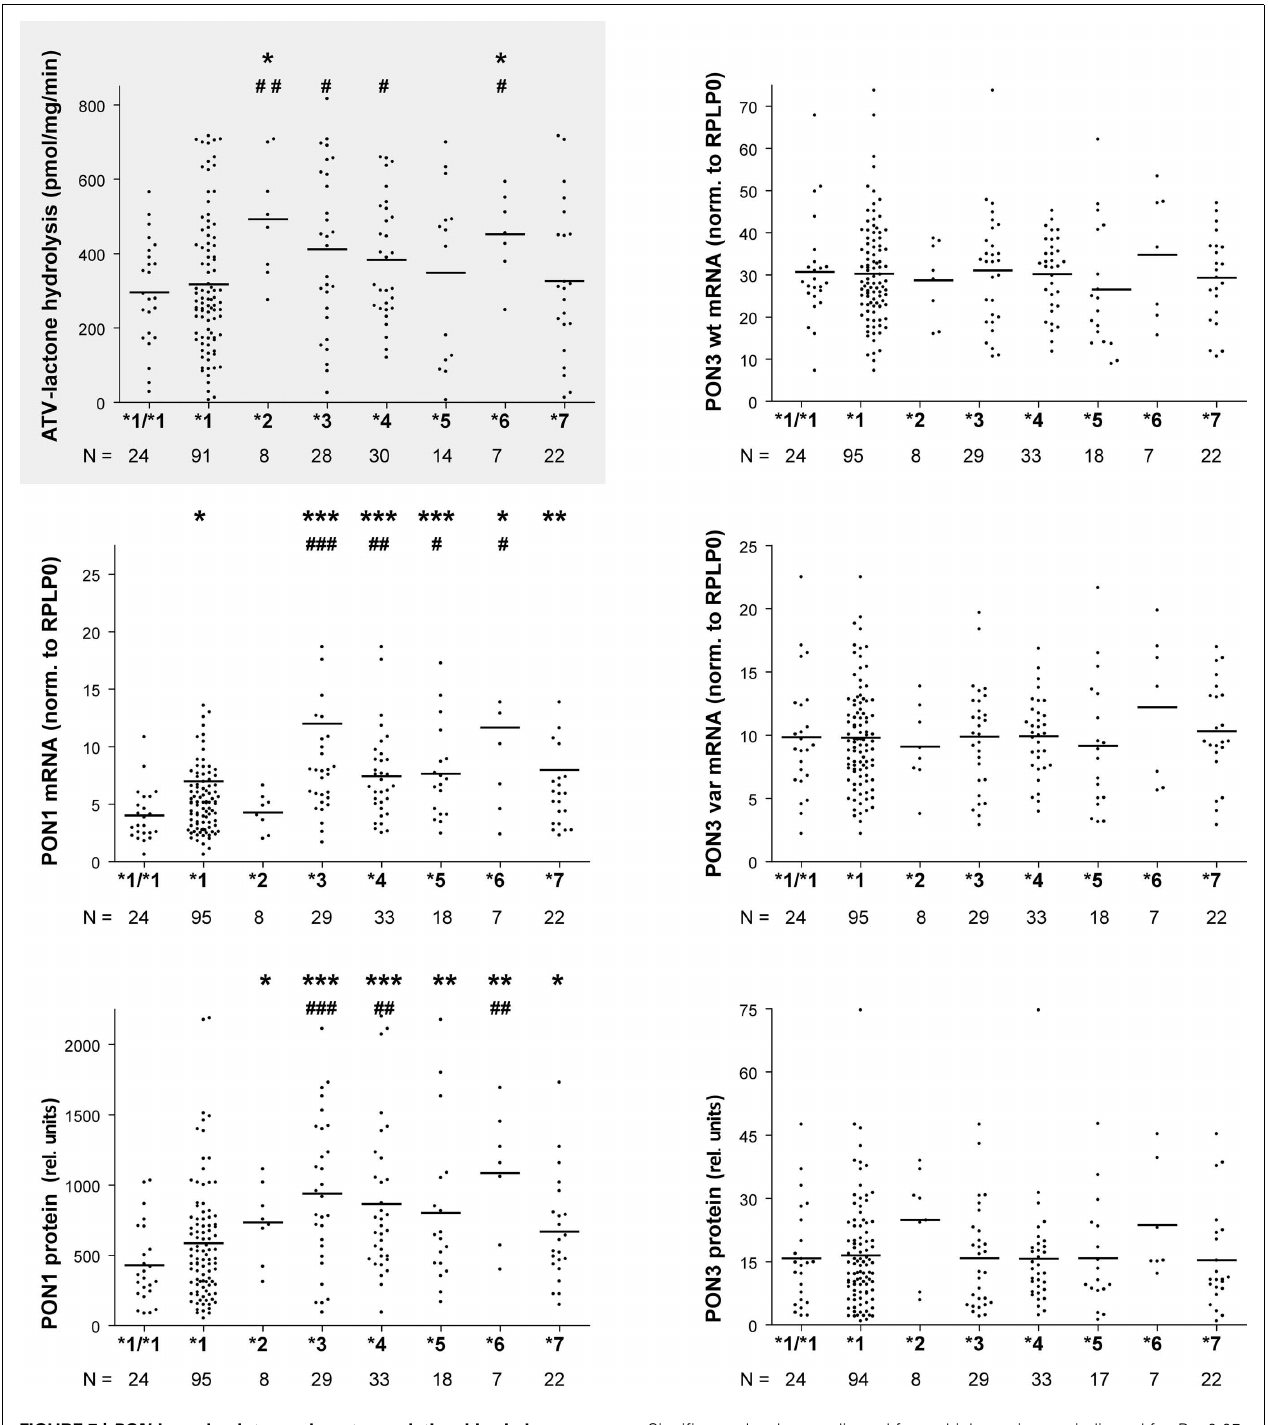
Significance levels not adjusted for multiple testing are indicated for P < 0.05 (* or #), P < 0.01 (** or ##), and P < 0.001 (*** or ###). After adjusting for multiple testing *3 , *4 , *5 , *7 against *1 / *1 or *3 and *4 against *1 were significantly different on PON1 mRNA level and *2 to *7 against *1 / *1 or *3 , *4 , and *6 against *1 were significantly different on PON1 protein